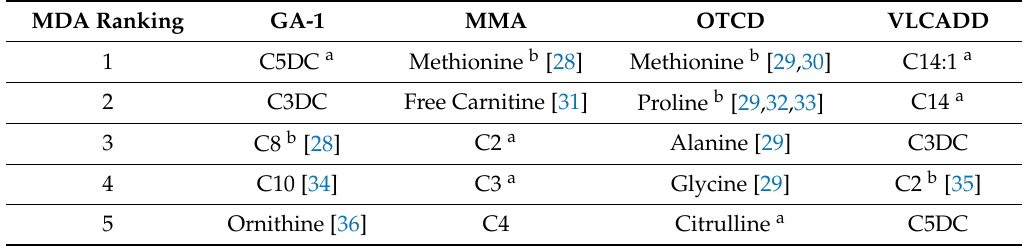
Table 3. The five top-ranked analytes identified by Random Forest for each